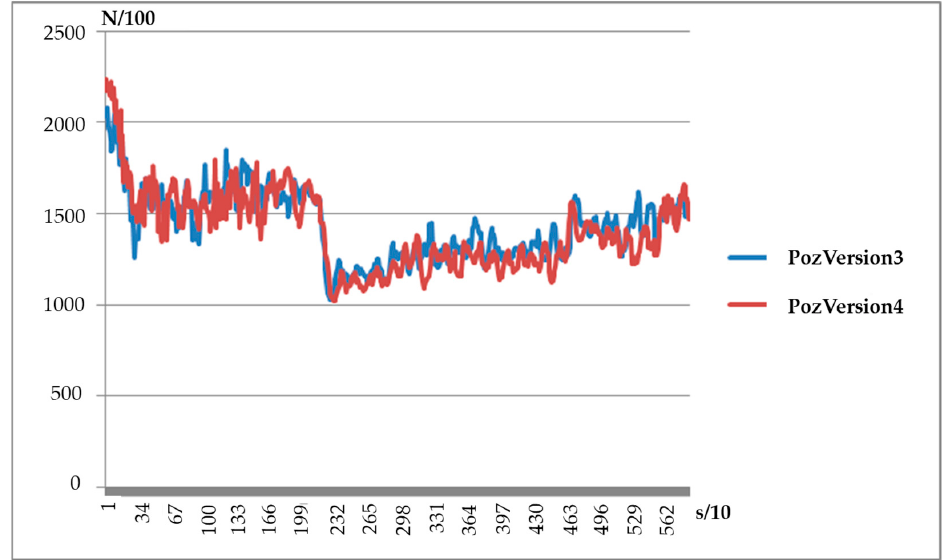
Figure 13. Tool weight compensation.